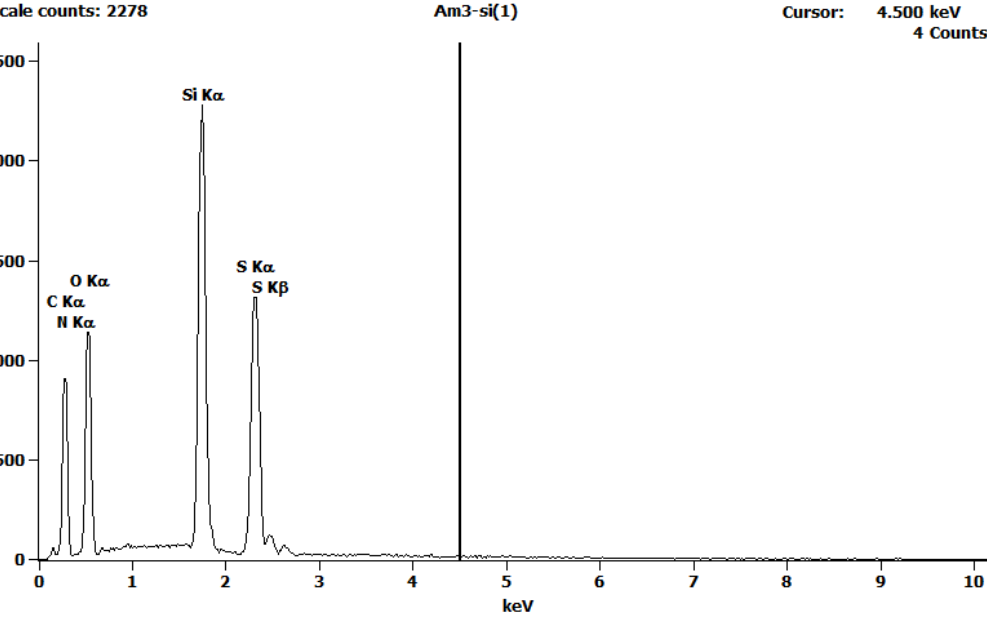
Figure 6. Energy-dispersive X-ray spectroscopy (EDX) spectrum of adsorbent 1 before adsorption .